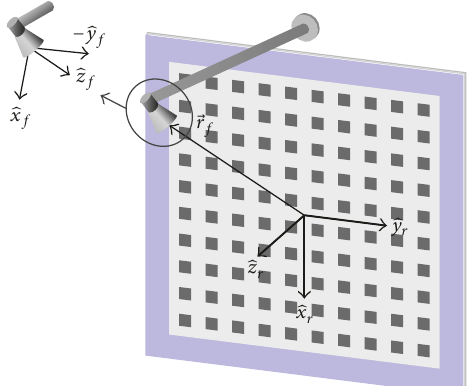
Figure 1: Sketch of the reflectarray single-offset geometry under study, with the dielectric frame in light blue color. It holds ̂𝑦 𝑟 = −̂𝑦 𝑓